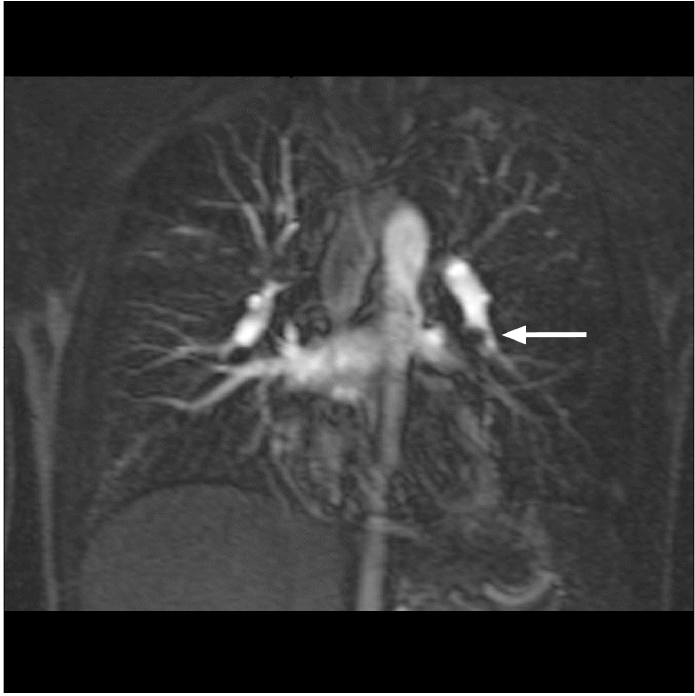
Figure 2. Pulmonary MRA in a 27-year-old male patient. Thrombus in the left pulmonary artery (see arrow) with hypoperfusion of the inferior pulmonary lobe and mild hypoperfusion in the right upper lobe. Good examination quality. Diseases 2022 , 10 , x FOR PEER REVIEW